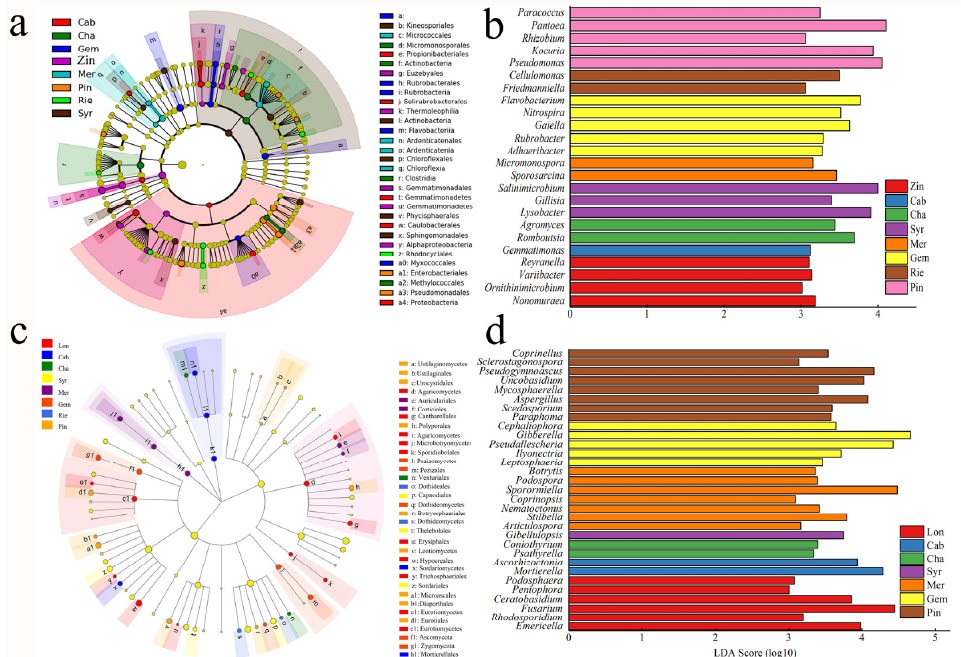
Figure 4. Cladograms suggesting the polygenetic distribution of bacteria ( a , b ) and fungi ( c , d ) in the rhizosphere of nine grape varieties as determined by linear discriminant analysis (LDA) effect size (LEfSe). Zinfandel (Zin), Cabernet Sauvignon (Cab), Syrah( Syr), Merlot (Mer), Gem (Gem), Pinot noir (Pin), Riesling (Rie), Longan (Lon), Chardonnay